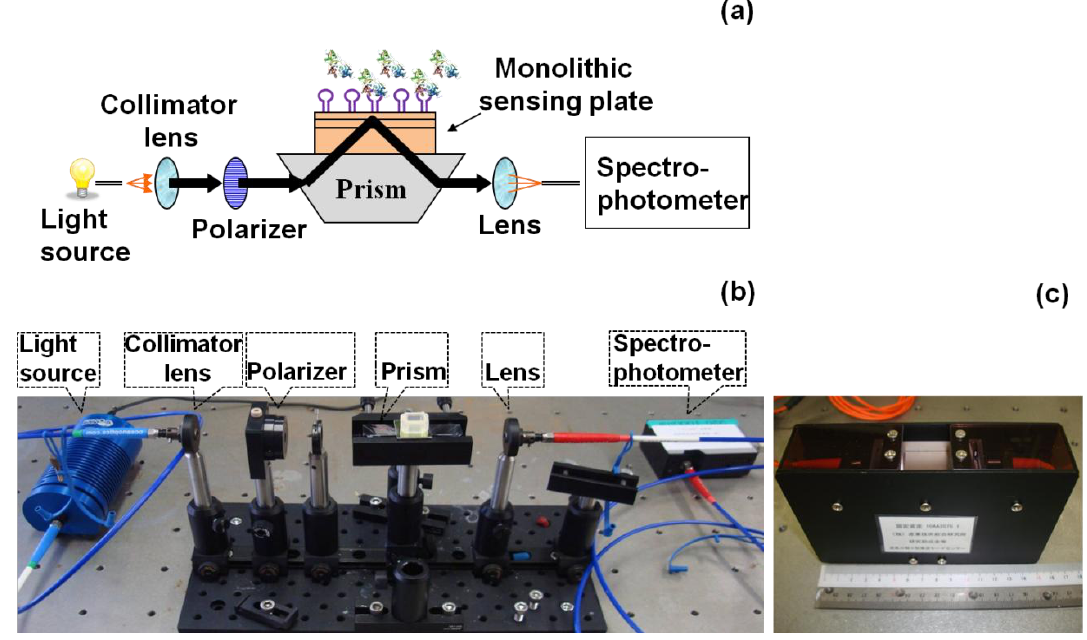
Figure 8. Proposed assays on waveguide-mode sensor using aptamer and ligands.